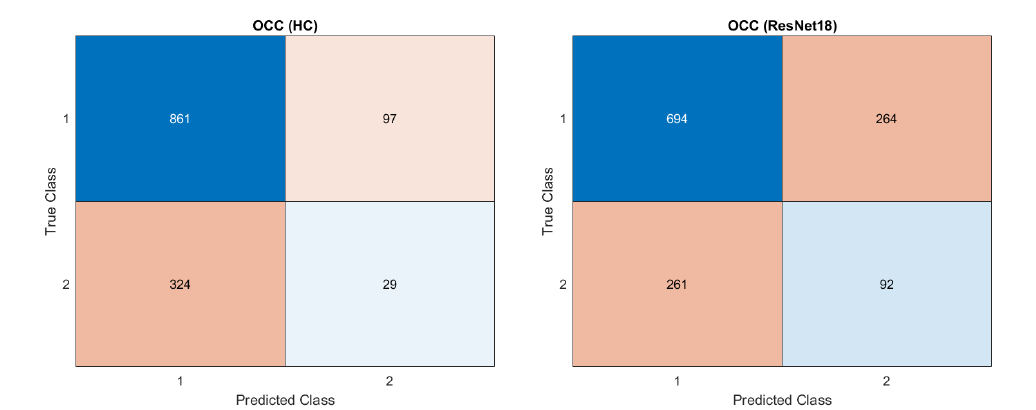
Figure A7. Confusion matrices for the OCC algorithm trained with handcrafted ( left ) and ResNet18 ( right )